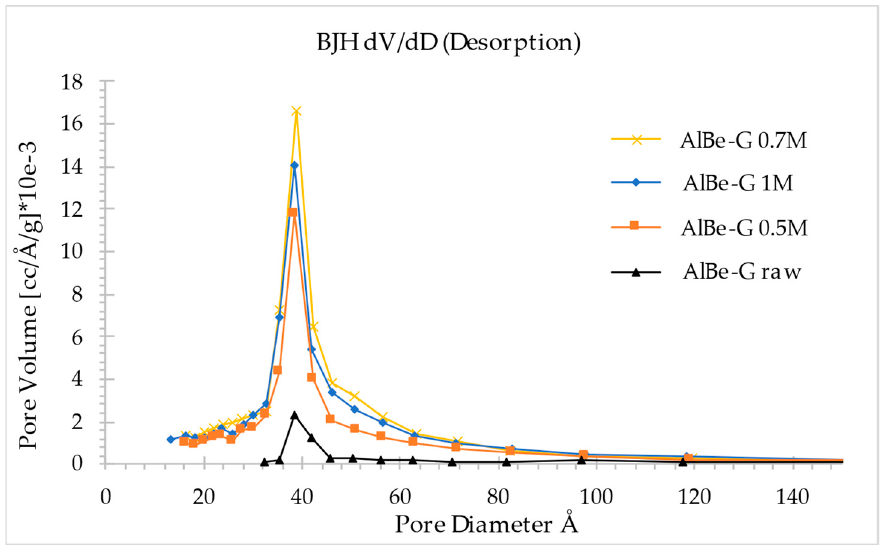
Figure 6. Pore size distribution of AlBe-G samples (80 °C; acid concentrations of 0.5 M, 0.7 M and 1 M; 2% of pulp density). 1 M; 2% of pulp density).